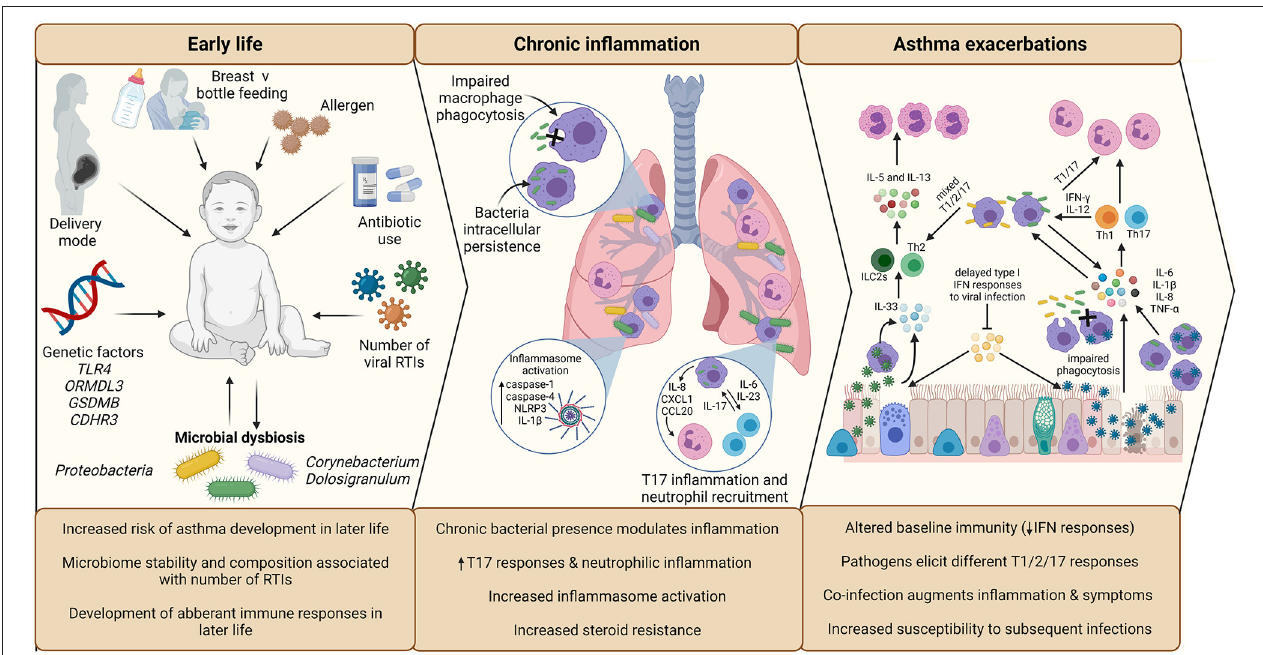
FIGURE 2 | Overview of the impact of infection in early life asthma development, on chronic inflammation in established asthma and during asthma exacerbations. The development and stability of the microbiome in early life is associated with allergen exposure, mode of delivery, feeding method, and antibiotic use. The composition of the microbiome is associated with the number of RTIs during infancy, which is subsequently associated with increased risk of asthma development in later life. Microbial dysbiosis resulting in microbiome profiles enriched in Proteobacteria particularly is associated with development of asthma and aberrant immune responses in later life. During established asthma, chronic colonization of the airway by Proteobacteria is associated with modulation of airway inflammation. NTHi persistent airway colonization causes inflammatory responses switching to T17, neutrophilic inflammation, increased inflammasome activation, which is linked to increased steroid-resistance. As a possible consequence of chronic bacterial colonization, baseline immunity in asthma is altered, including decreased antiviral immunity (IFN responses) and macrophage function (phagocytic ability). Viral infection is established due to delayed antiviral responses, which causes increased asthma symptoms, resulting in a virally driven exacerbation. Different viruses cause different disease pathology (e.g., increased cellular cytotoxicity following IAV infection compared to RV) and induction of T2-low (IAV) or T2-high (RV) responses. Bacterial infection also causes exacerbations and are likely contributors to exacerbation symptoms following viral infection, as bacterial outgrowth occurs due to impaired phagocytosis and macrophage immune response sensitization induced by viral infection. Again, different bacteria induce different responses, with Mcat reported to induce a mixed T1/2/17 response, whereas NTHi drives a T1/T17 pro-inflammatory response. Co-infection can augment inflammation and asthma symptoms, which may impact on treatment failure/success during exacerbation. Created using